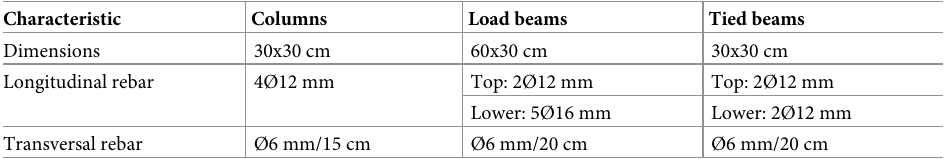
Table 1. Characteristics of the RC frames.